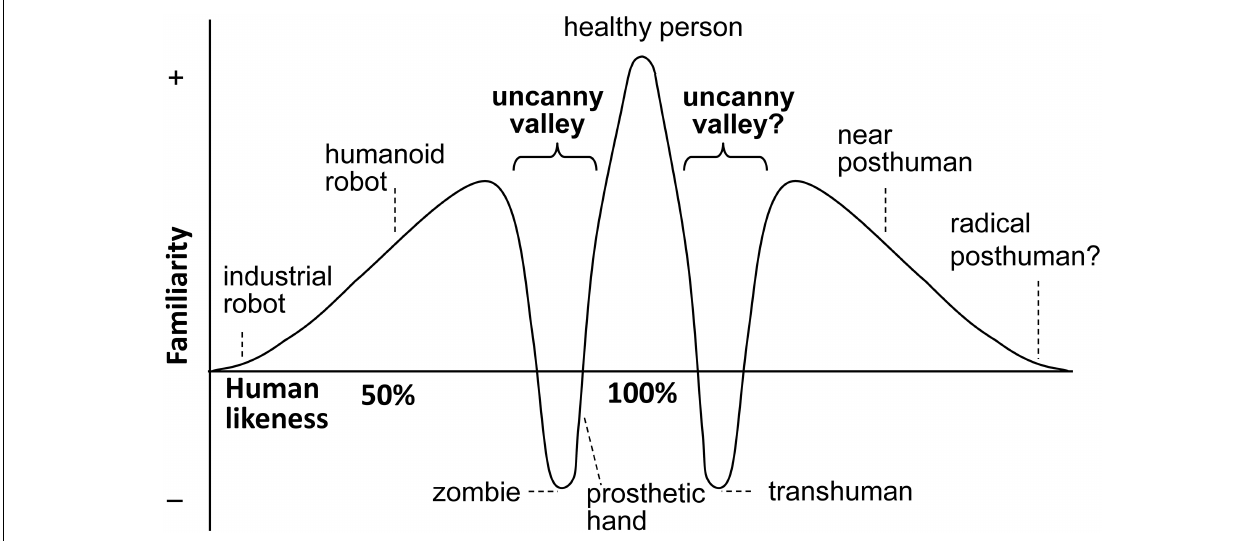
FIGURE 2 | An extended version of Mori’s idea by Jamais Cascio (from http://www.openthefuture.com/2007/10/the_second_uncanny_valley.html). The second valley shows a similar effect related to robots evolved from perfect humanlike agents, as they become less similar to humans – following the path of trans- human and, eventually, post- human robots. The hill after the valley is when differentiation is strong enough to create a new